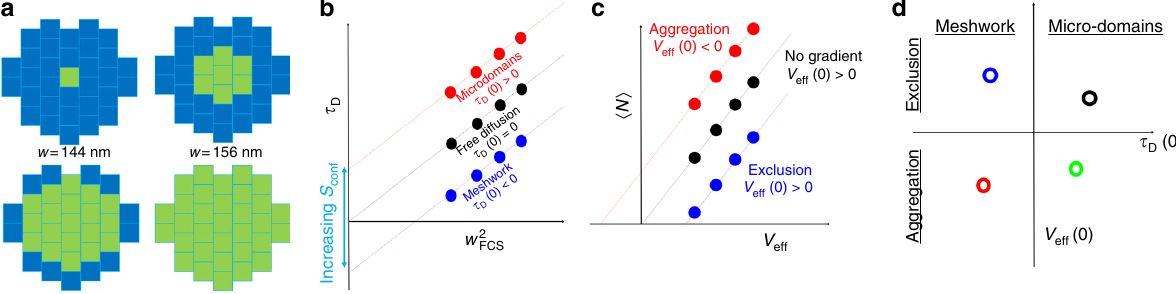
Fig. 1 a Schematic of the location of the detectors used (green) for obtaining variable waists of the PSF for the spot-variation analysis, together with measured waist relative to each con fi guration. b Schematic of the spot-variation principle for the diffusion time. The linear fi tting (dashed lines) of the measured diffusion time as a function of the effective waist squared returns an intercept value. τ D (0) < 0 in the case of diffusion in a meshwork, τ D (0) = 0 for free diffusion and τ D (0) > 0 in the case of diffusion in microdomains. c Schematic of the spot-variation principle for the average number; the linear fi tting (dashed lines) of the measured number as a function of the effective volume will return an intercept value V eff (0) 0 in the case of aggregation, V eff (0) > 0 for exclusion and V eff (0) = 0 if no gradient is present. d Scheme of intercept plot. Each measurement results in a single point in the intercept plot, which shows if the environment is meshwork- (red and blue) or microdomain-like (black and green) and if the diffusing probe is undergoing exclusion (blue and black) or aggregation (red and